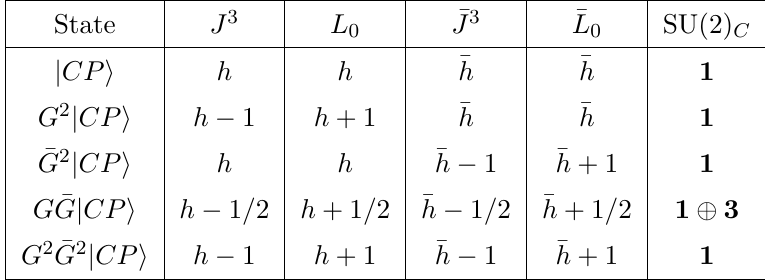
Table 1 . Bosonic structure of the short